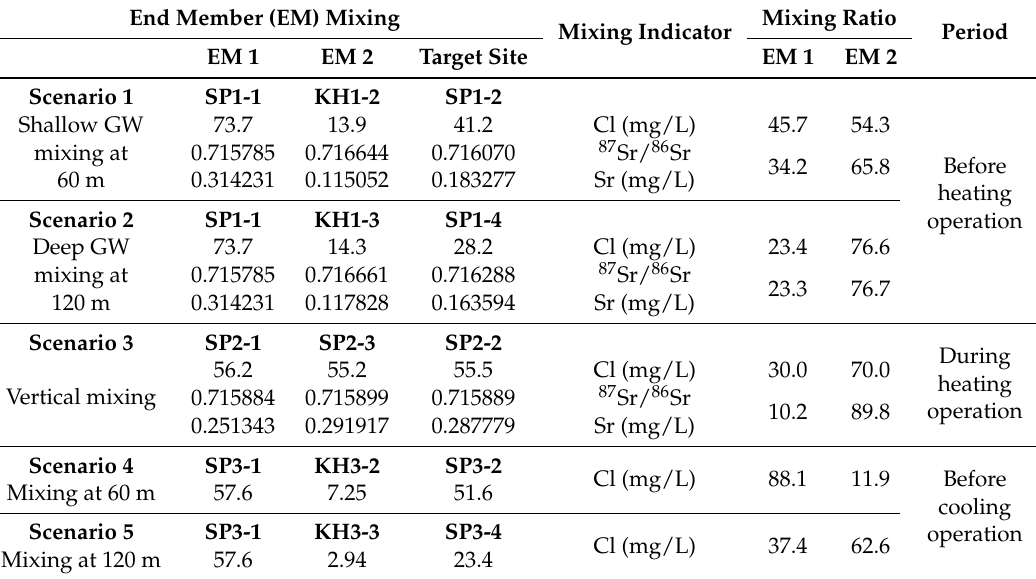
Table 2. Calculated mixing ratios using conservative Cl ion and 87 Sr/ 86 Sr